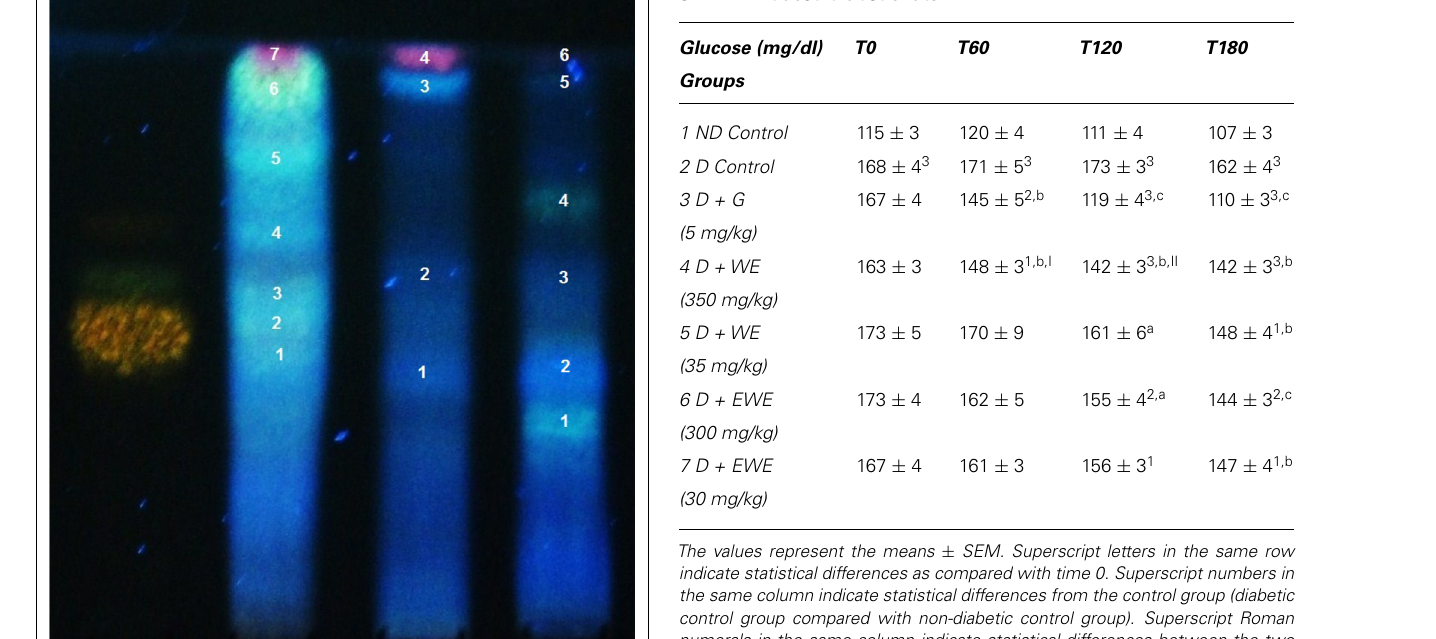
Table 1 |Acute hypoglycemic effects of Bromelia plumieri leaves on STZ-NA-induced diabetic rats.